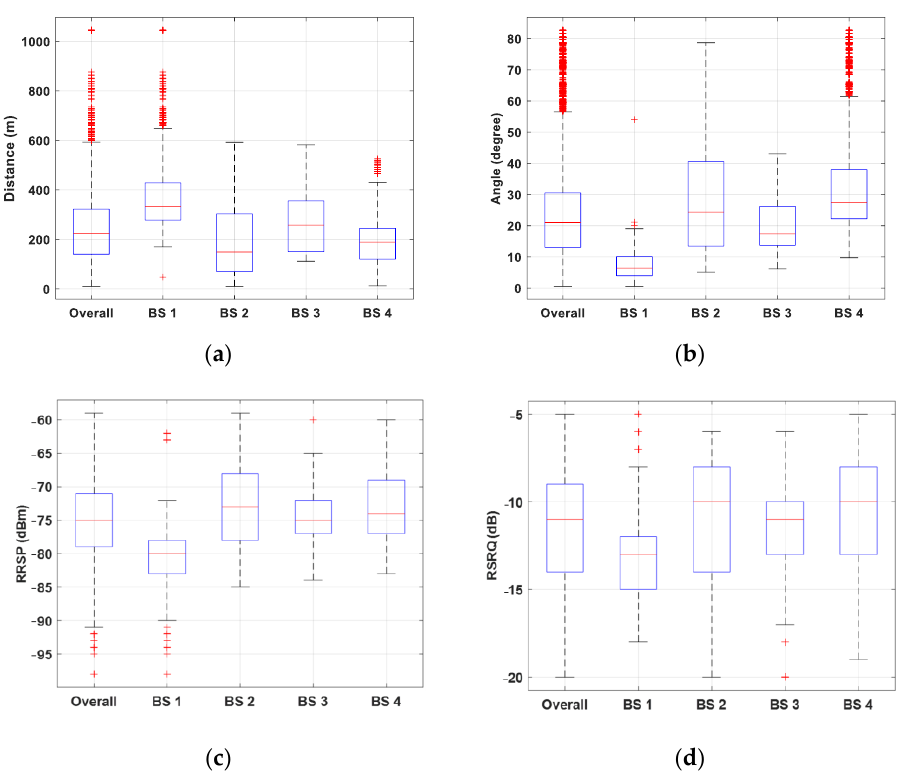
Figure 5. Box plot of ( a ) distance, ( b ) elevation angle, ( c ) RSRP, and ( d ) RSRQ of the overall dataset and considered BSs.